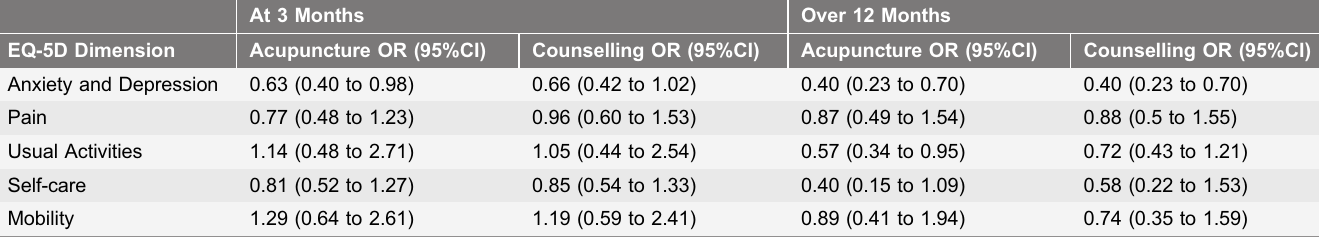
Table 1. The proportional odds of being at level 2 or 3 compared with level 1* compared with usual care.